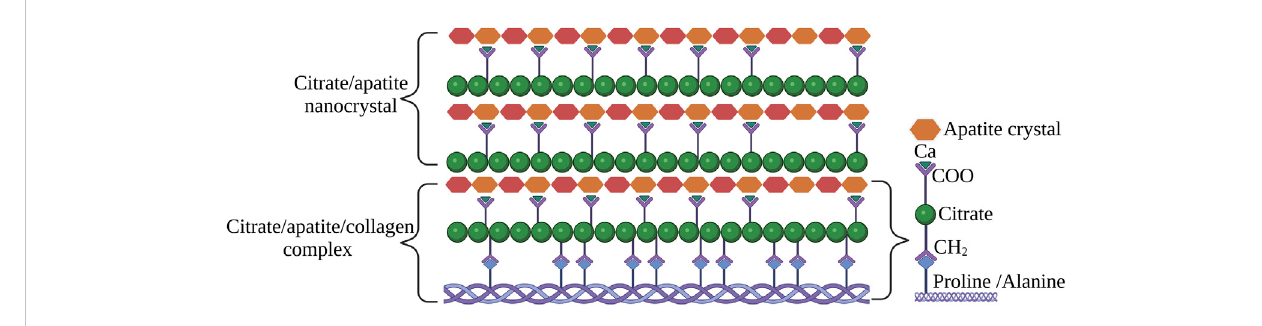
FIGURE 7 The status of citrate in apatite/collagen component of bone. The image is inspired by the artwork of (Costello et al.,